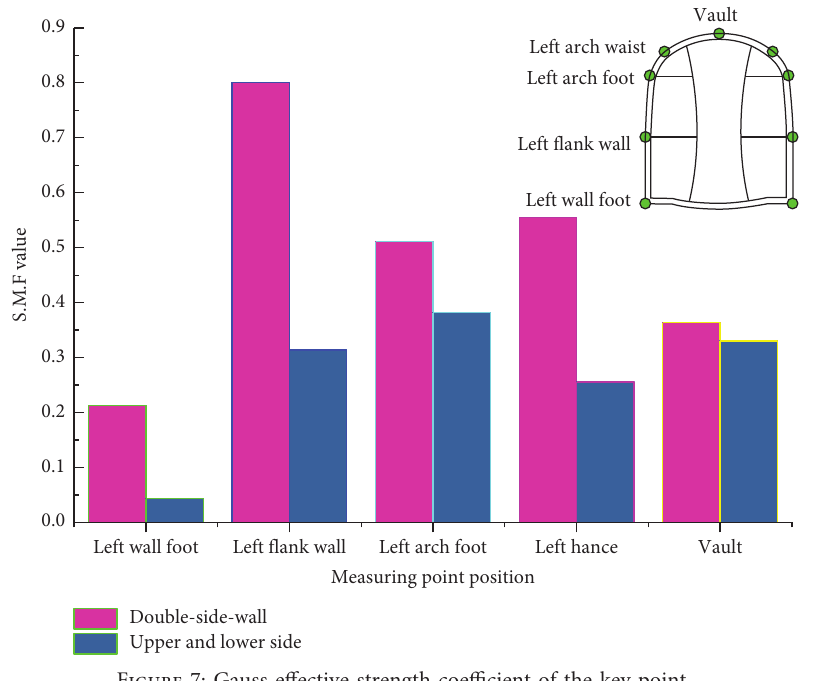
Figure 7: Gauss effective strength coefficient of the key point.